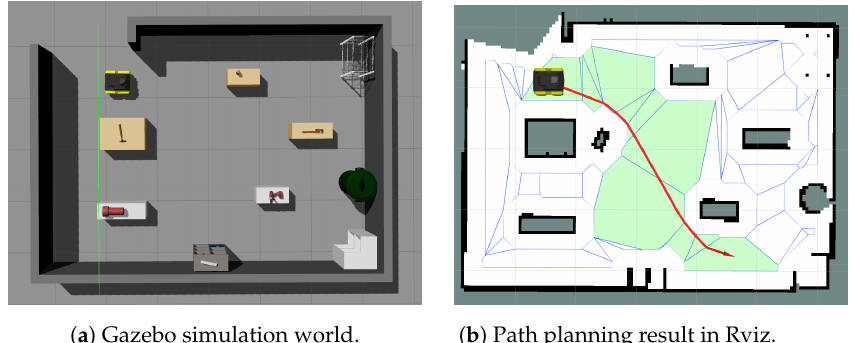
Figure 8. Toolbox’s result on a grid map obtained from a Gazebo